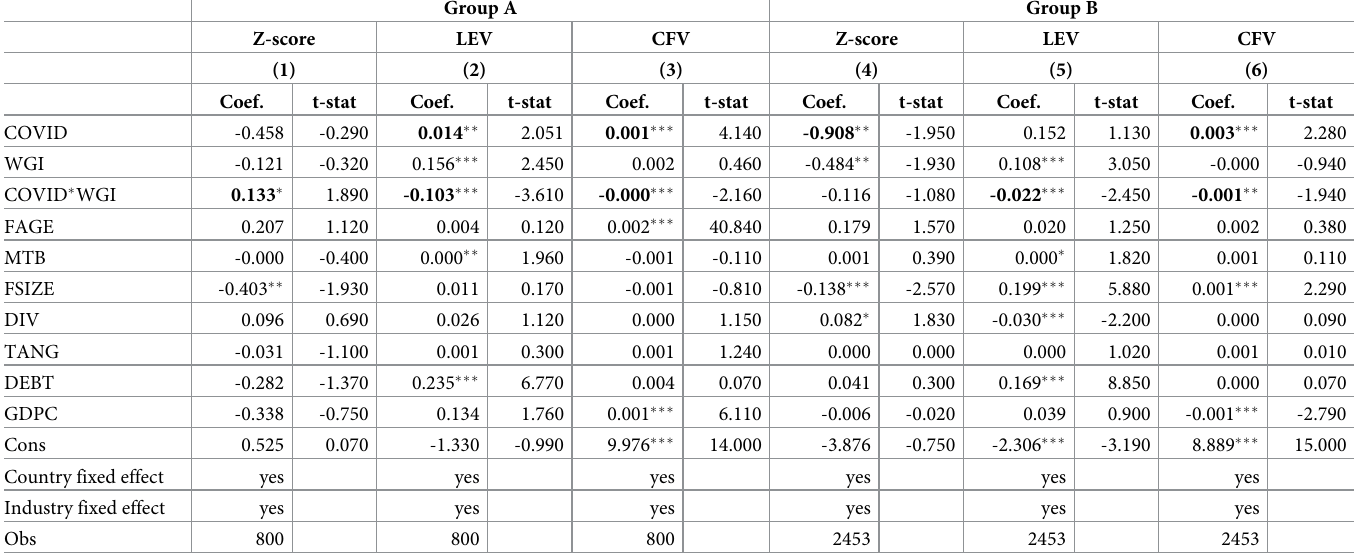
Table 8. COVID-19 crisis and firm risk by